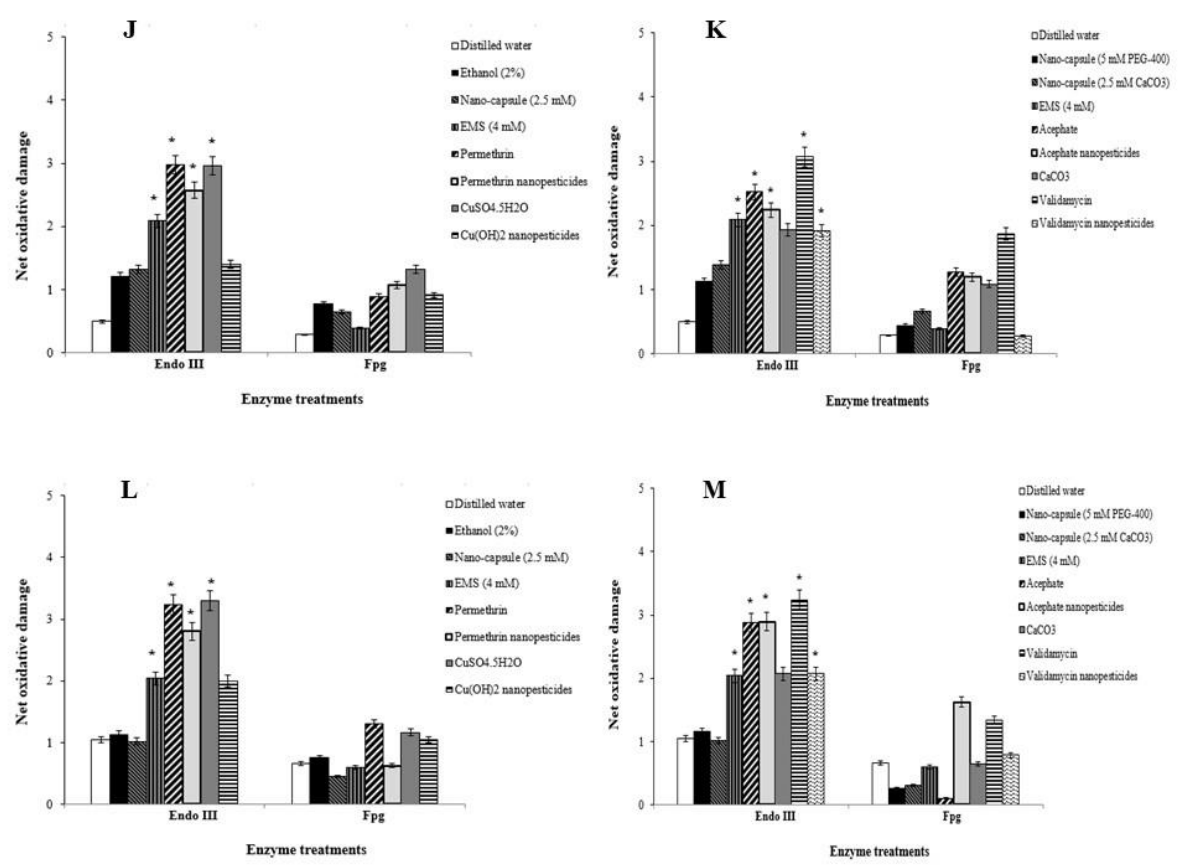
Figure 11. Genotoxic effects of permethrin ( A ), permethrin nanopesticides ( B ), CuSO 4 · 5H 2 O ( C ), Cu(OH) 2 nanopesticides ( D ), acephate ( E ), acephate nanopesticides ( F ), validamycin ( G ), validamycin nanopesticides ( H ) , and CaCO 3 ( I ) in the comet assay. Results indicate the % DNA tail induced after the larvae were exposed to different doses of permethrin and permethrin nanopesticides for 24 h (three replicates were carried out, and 100 randomly selected cells were analyzed per treatment). Net oxidative damage induction in hemocytes and midgut cells after exposure to permethrin and permethrin nanopesticides at doses of 0.1 and 2.5 mM during the larval stage; effects induced by buffer exposure were subtracted from those obtained after enzyme treatments (Endo III and Fpg) ( J – M ). Data represent the mean ± standard error (SE) of the mean. EMS (4 mM) was used as a positive control; * p ≤ 0.05, *** p ≤ 0.001 when compared to the negative control using Student’s t -test.